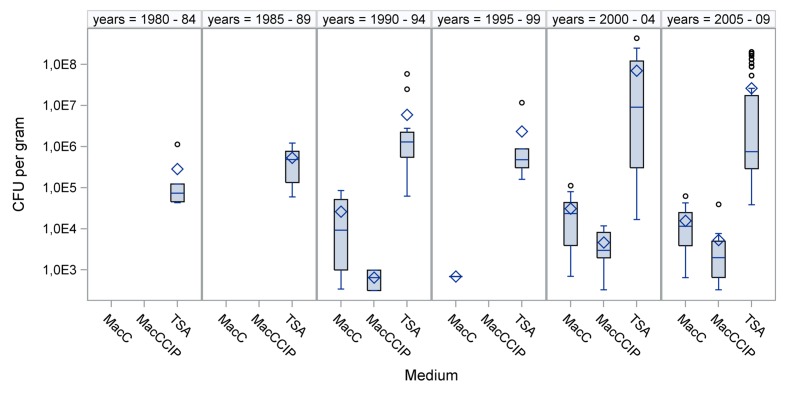
Bacterial concentrations in dusts collected during various time periods. Total viable bacteria were counted on TSA agar, and Escherichia coli were counted on MacConkey agar (MacC) and on MacConkey agar with ciprofloxacin (MacCCIP). ◊ = arithmetic mean, ○ = outlier, – = median